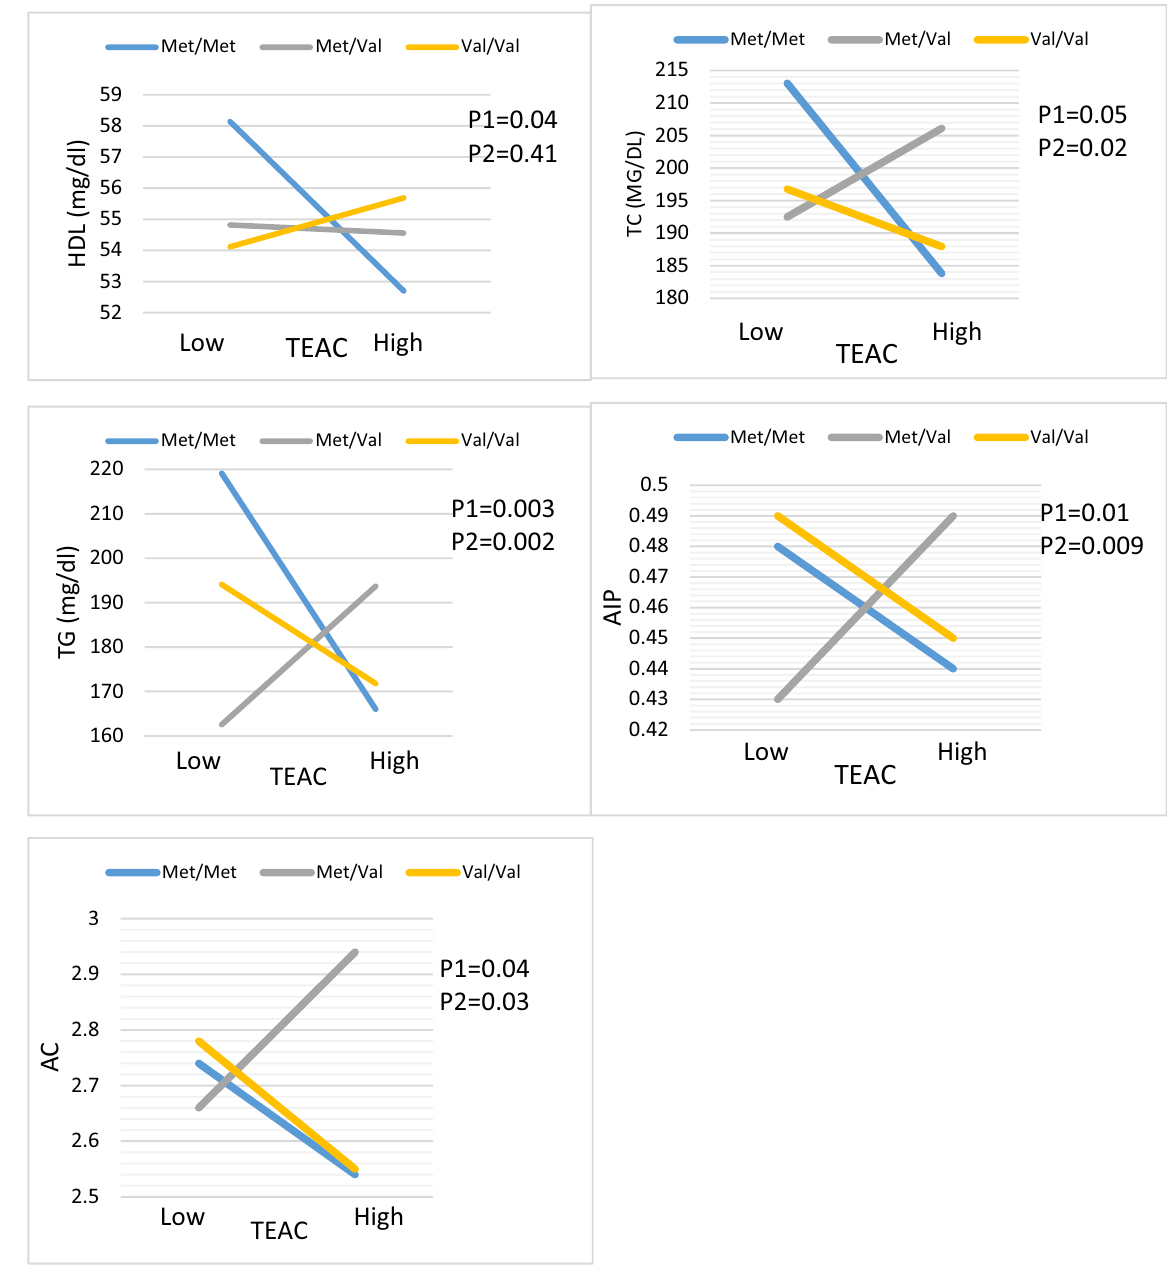
Figure 3. Interaction between the BDNF Val66Met polymorphism and DTAC (TEAC) intake with regard to TG, HDL, AIP and AC according to the median DTAC, the participants were dichotomized into low and high categories. P 1 = P value with unadjusted (crude) model, P 2 = P value with adjustments for potential confounding factors including (Age, physical activity, sex, smoking, alcohol, energy intake, lipid, and glucose- lowering medicines, and family history of